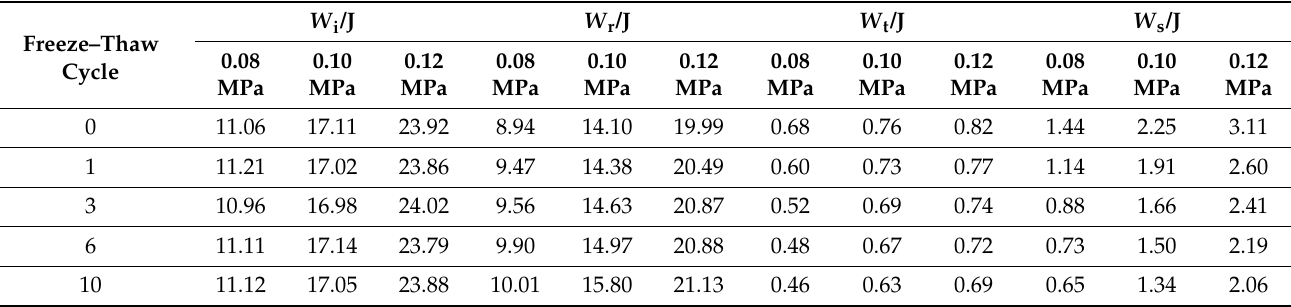
Table 5. Summary of energy